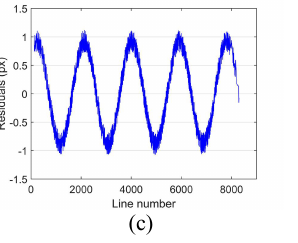
Figure 8. Registration residuals between the orthoimage and (a) B1, (b) B2, (c) B3, respectively